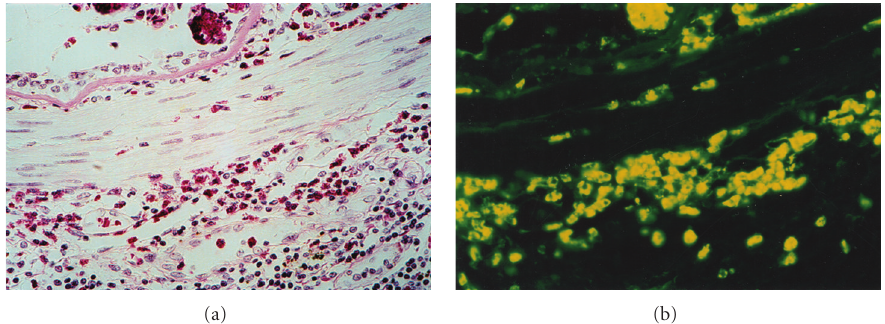
Figure 1: (a) Example of intense inflammatory infiltration of eosinophils into the lamina propria in airway of asthmatic patient (H&E stain; 600x). Note discrete localization of eosinophils within the ASM layer. (b) Example of immunofluorescence staining of MBP in the ASM layer of an asthmatic patient (anti-MBP; 600x). In addition to the lamina propria, MBP was clearly localized in the smooth muscle